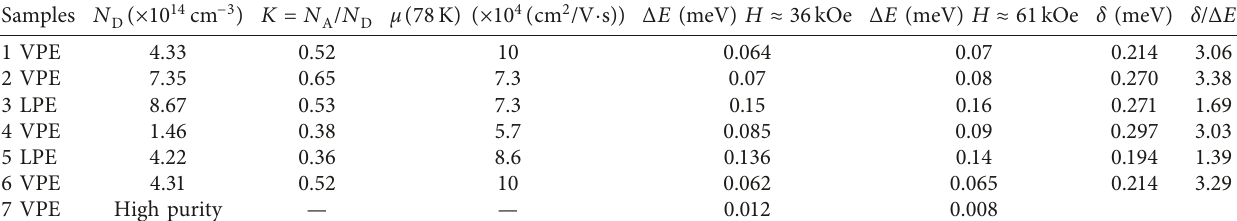
donor lines at different cyclotron 1